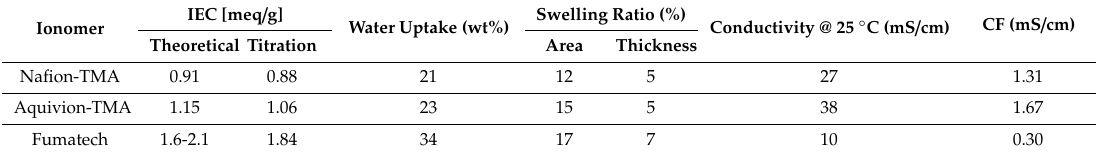
Table 1. Physical properties of Nafion-TMA, Aquivion-TMA, and Fumatech.